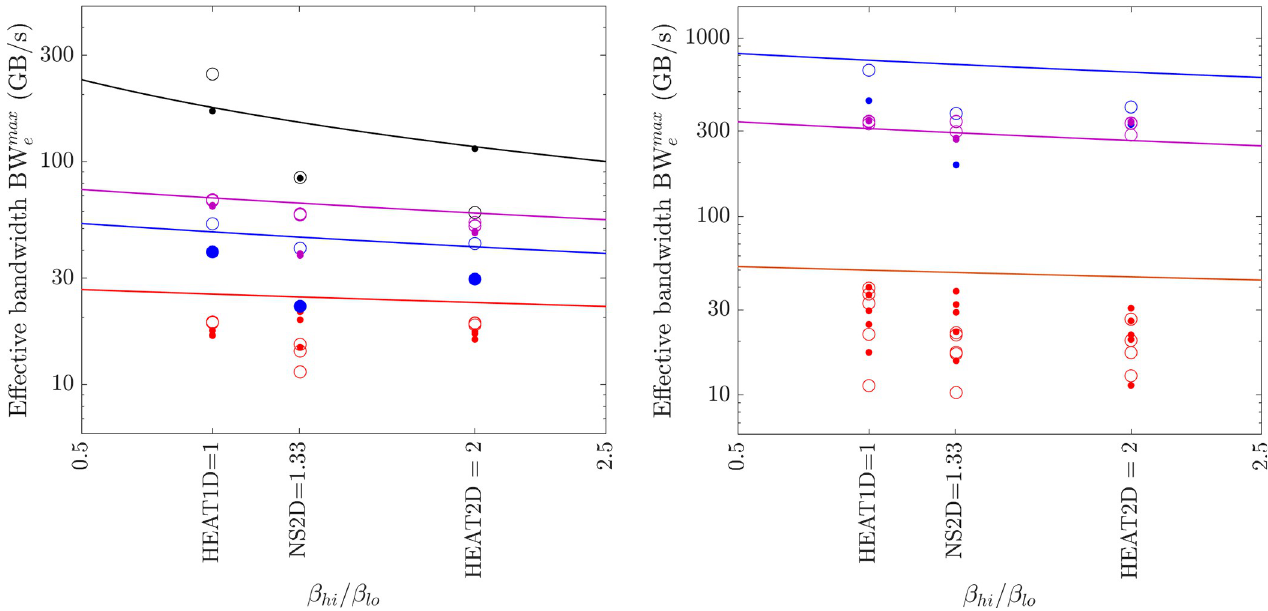
Fig 20. Model for the maximal effective bandwidth of numerical models (lines = model prediction by Eq 12; symbols = measured maximal effective bandwidth; filled = f64; hollow = f32; black = CPU medium; red = CPU large; blue = GPU medium; magenta = GPU large). (a) PC. (b) HPC.